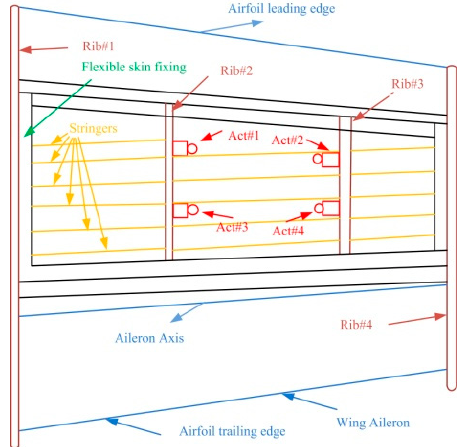
Figure 2. Morphing wing layout.